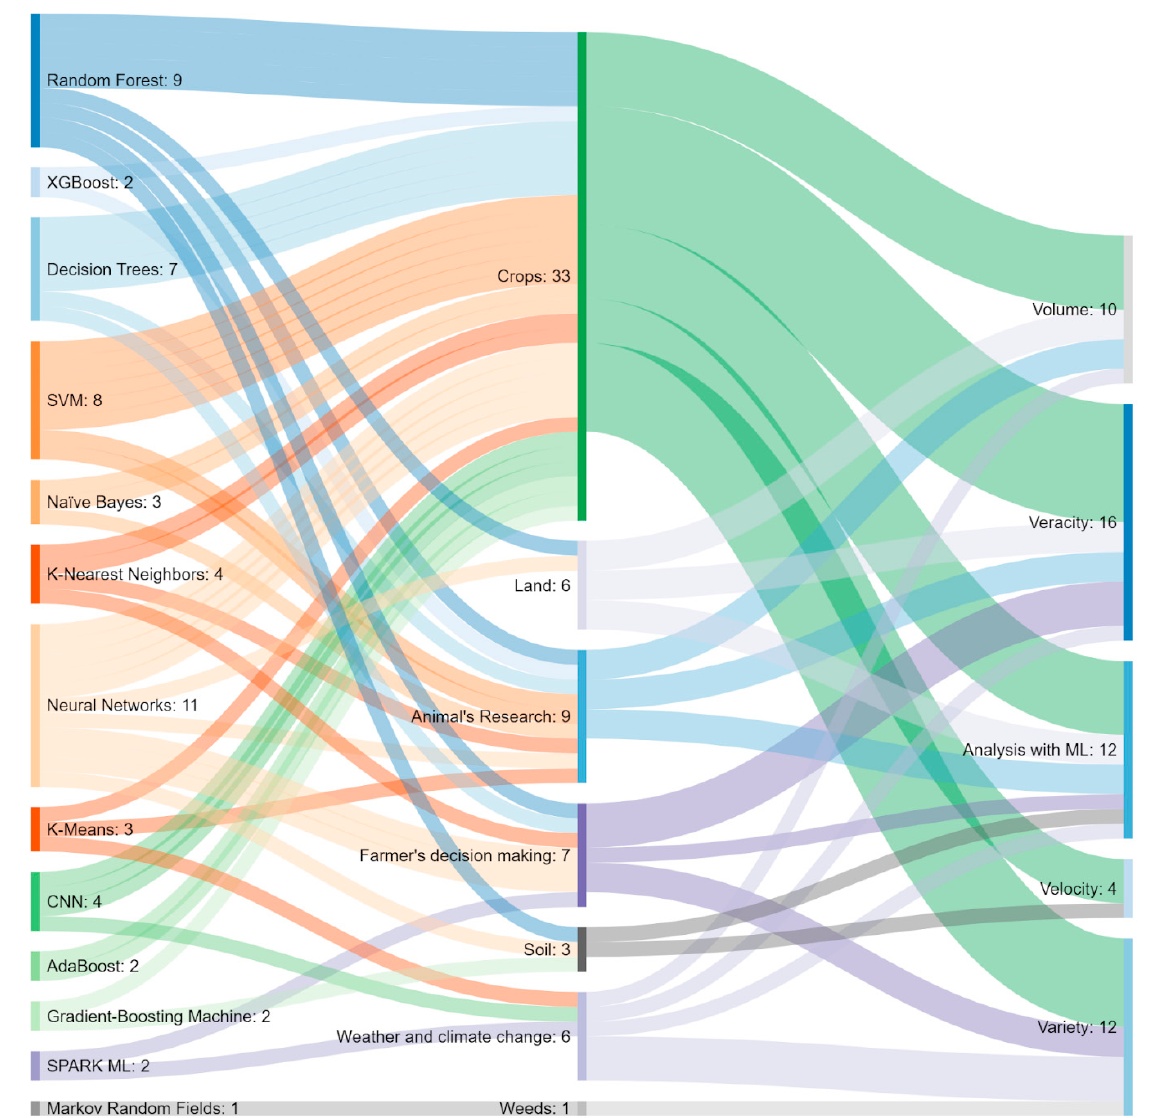
Figure 17. Relationship of the challenges between ML, the agriculture industry, and Big